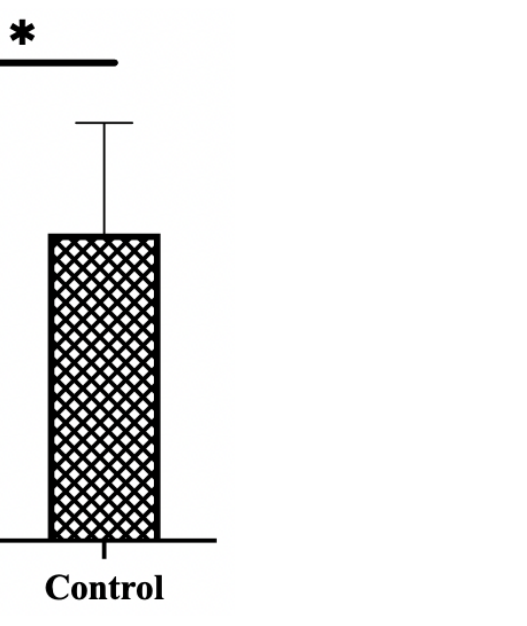
Figure 3. EGF concentration in breast milk. Error bars represent standard errors. * indicates p < 0.05.